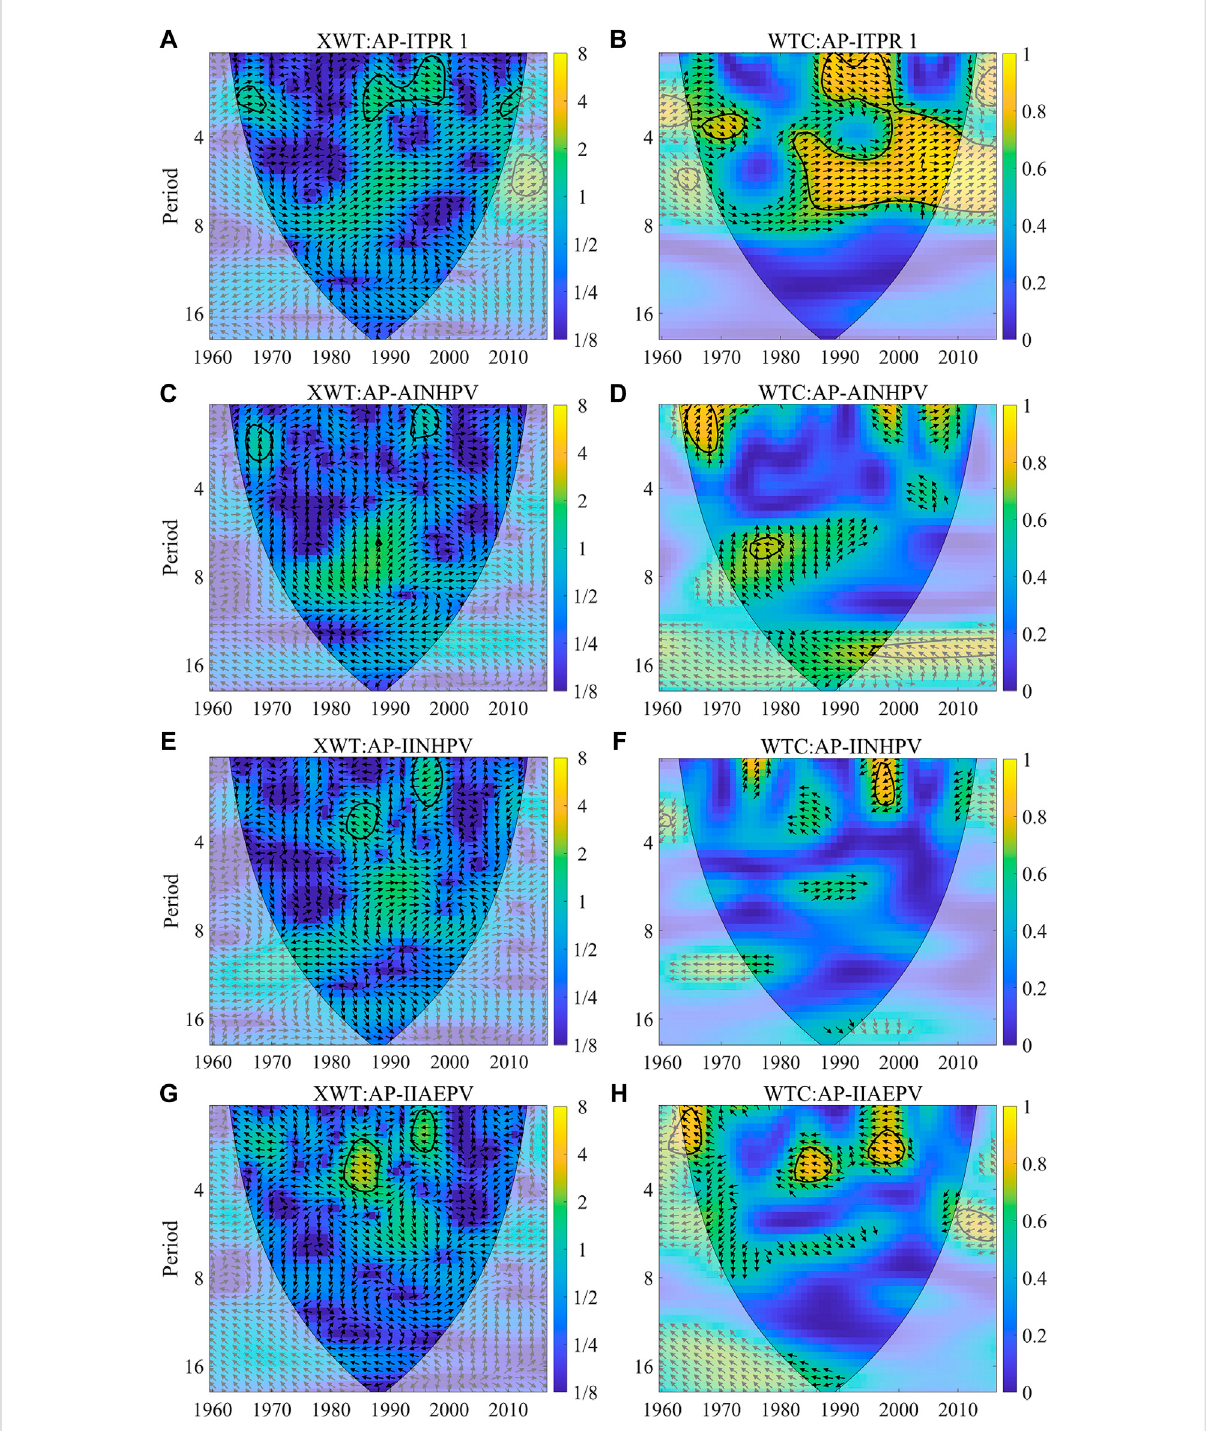
FIGURE 8 XWT and WCT of the annual precipitation (A – H) in XJ to the index of the Tibet Plateau Region 1 (ITPR 1), the area index of the Northern Hemisphere Polar Vortex (AINHPV), the intensity index of the Northern Hemisphere Polar Vortex (IINHPV), and the intensity index of the Atlantic- European PolarVortex